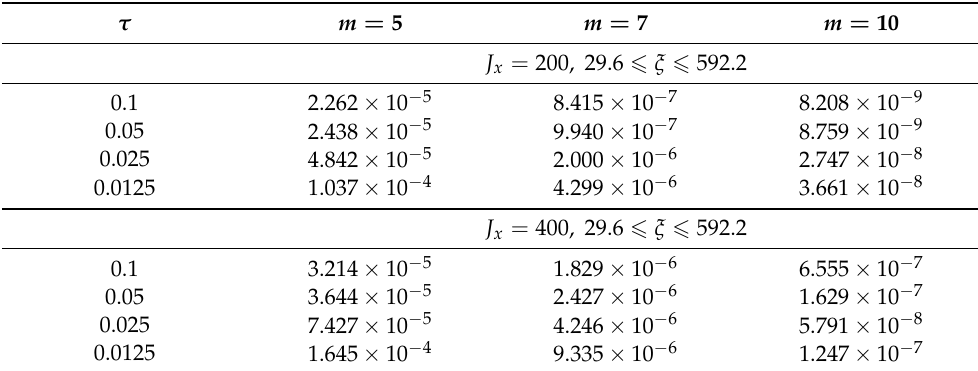
Table 4. Approximation errors (cid:107) (cid:101) Ψ n τ ( ξ ) (cid:107) for the discrete solution of the BURA-BRASIL scheme (16) in a reduced spectral interval. A sequence of time steps τ and J x = 200,400 are used.